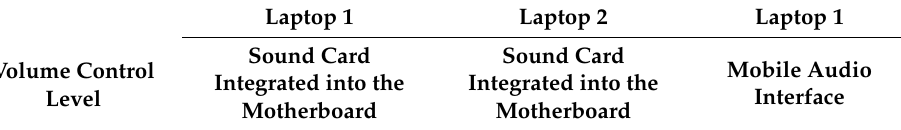
Table 1. Values of A-weighted equivalent sound pressure level of the test signal reproduced by various headsets that were directly connected to Laptop 1 and Laptop 2, and to Laptop 1 through a mobile audio